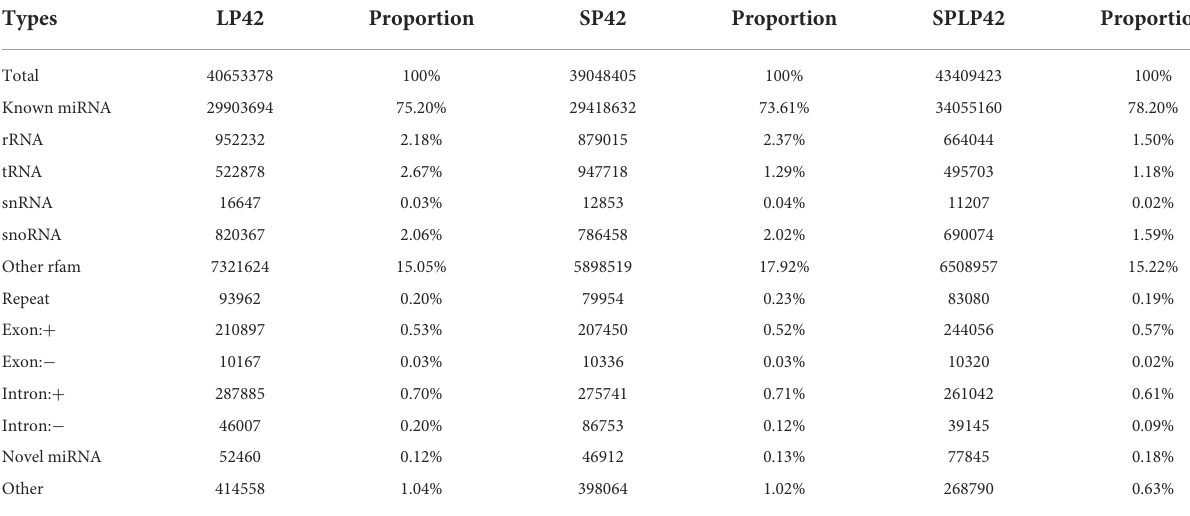
TABLE 2 Summary of the classification statistics of sRNA total reads mapped to reference